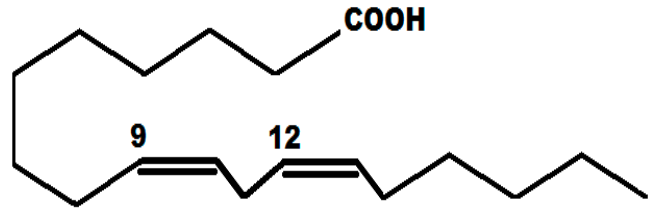
Figure 1. Chemical structure of α -linolenic acid.